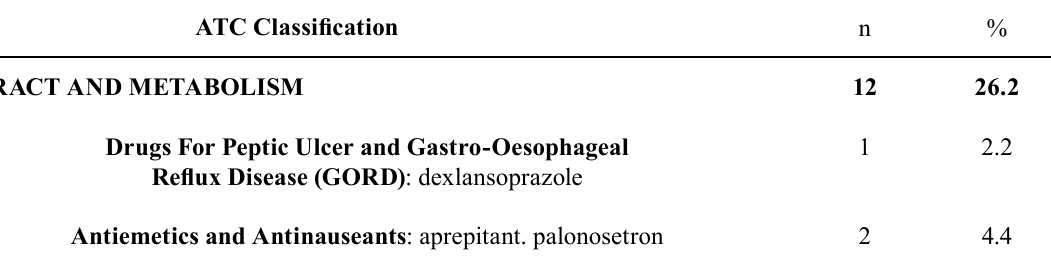
TABLE I – Anatomical Therapeutic Chemical Classification of the 46 pediatric drugs identified in the cohort of new drugs registered from 2003 to